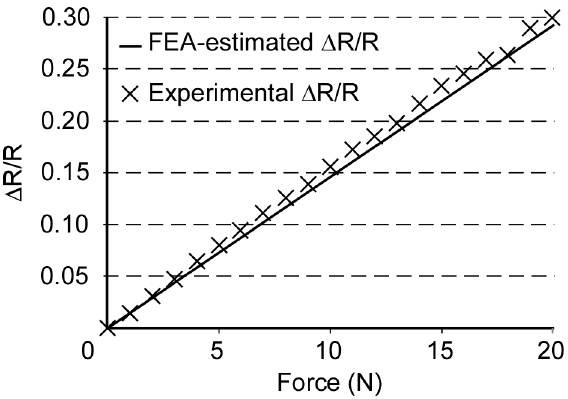
Figure 2. Comparison of experimental and FEA-estimated resistance change for an applied load on a test cantilever.